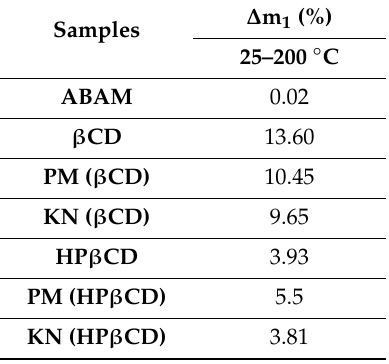
Figure 4. Thermogravimetry (TG) curves for ABAM, β CD, HP β CD and their respective ICs. ( A ) TG curves for ABAM- β CD obtained by PM and KND. ( B ) TG curves for ABAM-HP β CD obtained by PM and KND. Table 1. Loss of mass of ABAM, β CD, HP β CD and their respective ICs within the temperature range of 25–120 °C.